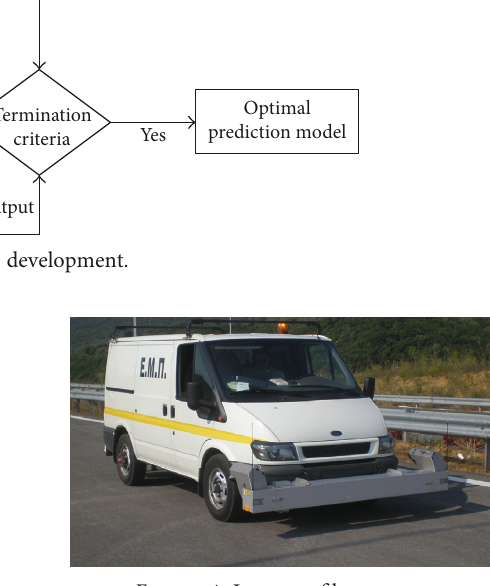
Figure 4: Laser profiler